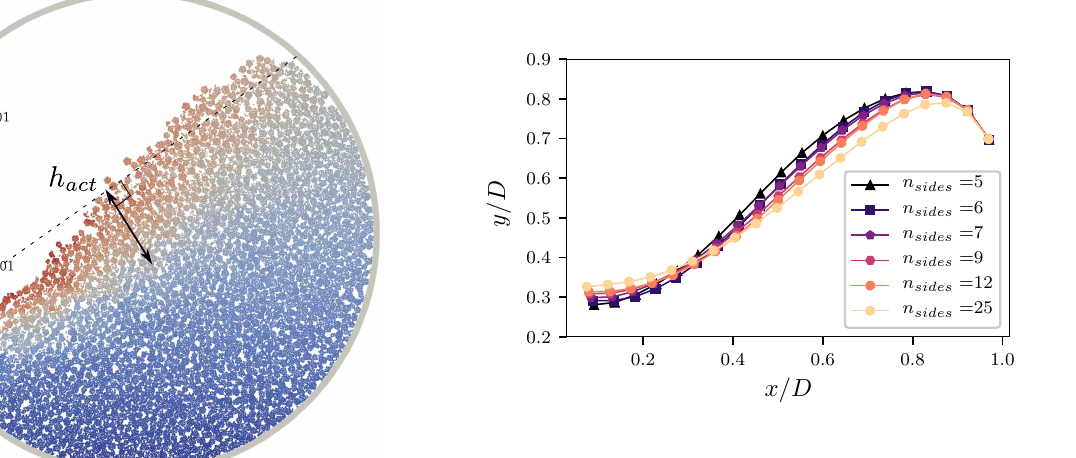
Figure 6. Free surface profiles for each sample of unbreakable polygons with di ↵ erent number of sides ( n sides